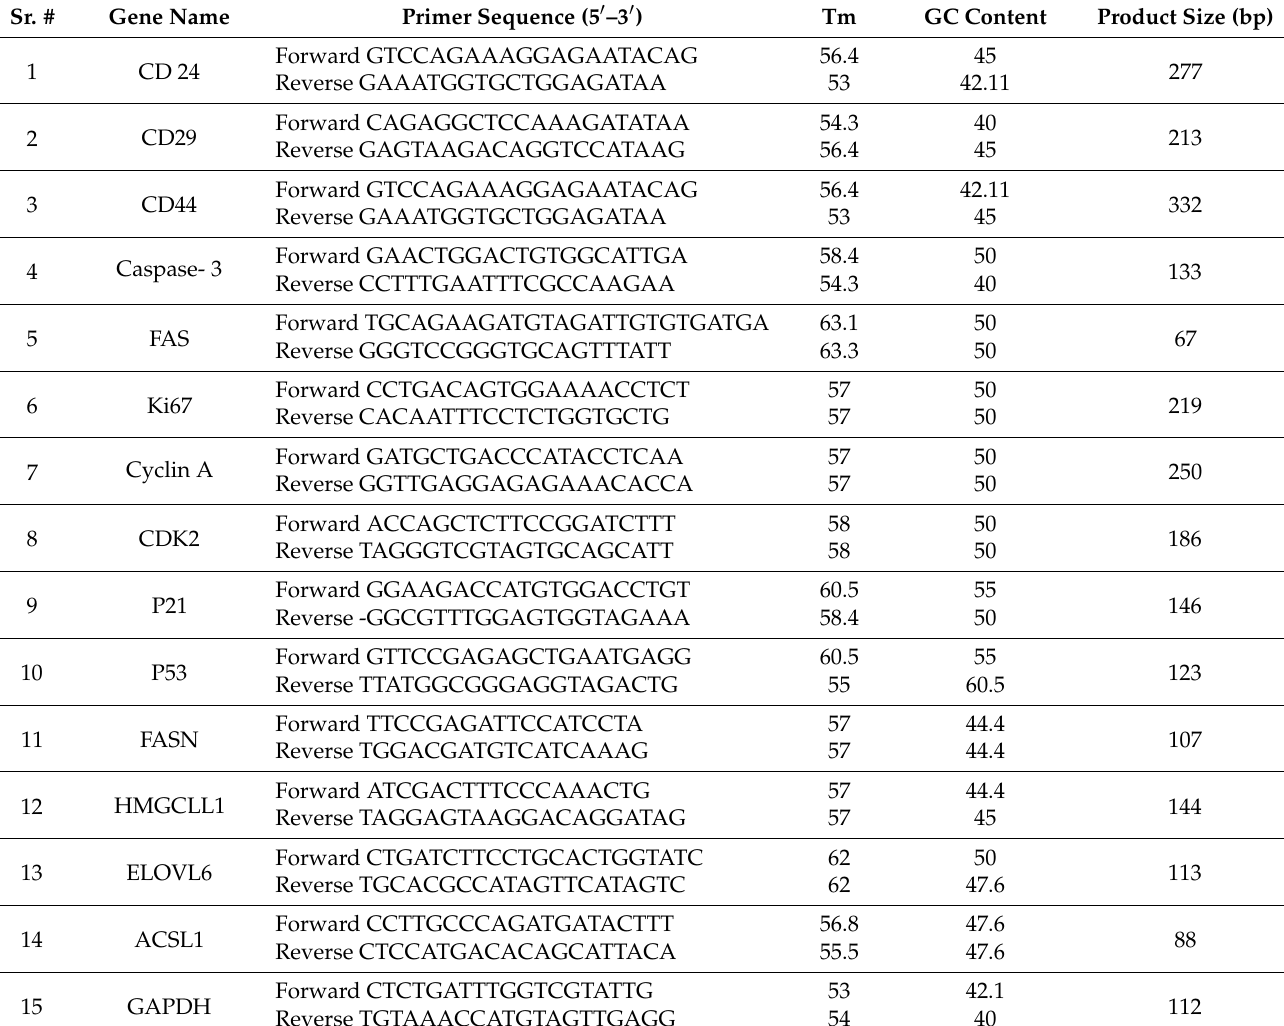
Table 1. List of primers used for this